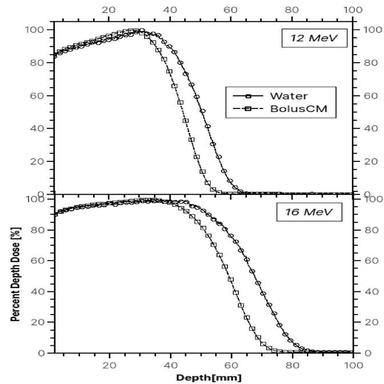
Calculated PDD in water and BolusCM due to 6 and 9 MeV electrons. Fig. 10. Calculated PDD in water and BolusCM due to 12 and 16 MeV electrons.